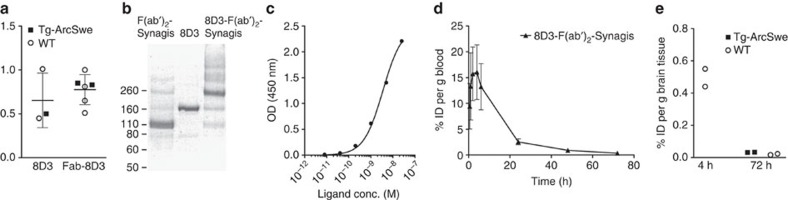
Brain distribution of 8D3 and generation of an Aβ irrelevant fusion protein.(a) Brain distribution of 8D3 (n=3) and Fab-8D3 (n=6) in 10- to 12-month-old WT and tg-ArcSwe mice 4 h post injection, demonstrating that the TfR-mediated transcytosis of 8D3 is Fc-independent. (b) SDS–PAGE displaying F(ab′)2-Synagis, TfR antibody 8D3 and the fusion protein consisting of F(ab′)2-Synagis and 8D3. (c) TfR ELISA demonstrating that the irrelevant fusion protein binds to TfR in vitro. (d) In vivo blood pharmacokinetics of irrelevant fusion protein in tg-ArcSwe (n=2) and WT mice (n=4): the irrelevant fusion protein showed a similar half-life as the 8D3-F(ab′)2-h158 fusion protein (11 h). (e) Comparison of irrelevant fusion brain concentration at 4 h (Cmax), demonstrating an increased transport across the BBB in WT mice (n=2), and at 72 h post injection, where the low concentration of irrelevant fusion protein in both tg-ArcSwe (n=2) and WT (n=2) mice reflects the lack of target in the brain. The symbols and error bars indicate group mean±s.d. (d). Each symbol represents one animal (a and e). SDS–PAGE, SDS–polyacrylamide gel electrophoresis.